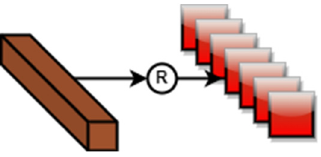
Figure 8. Framework for 3D to 2D feature deformation.